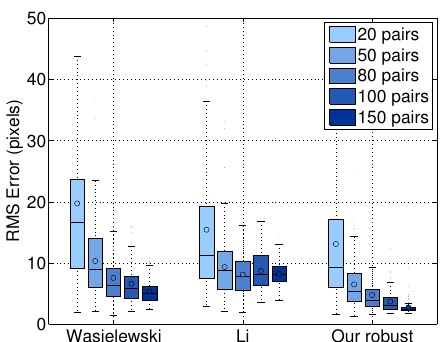
Figure 9. Performance as a function of number of image and LiDAR scan pairs: we used a 10-fold cross-validation to evaluate the effect that the number of calibration data has on the calibration accuracy. Our approach was also affected by the number of calibration data, but the effect was smaller than other approaches.